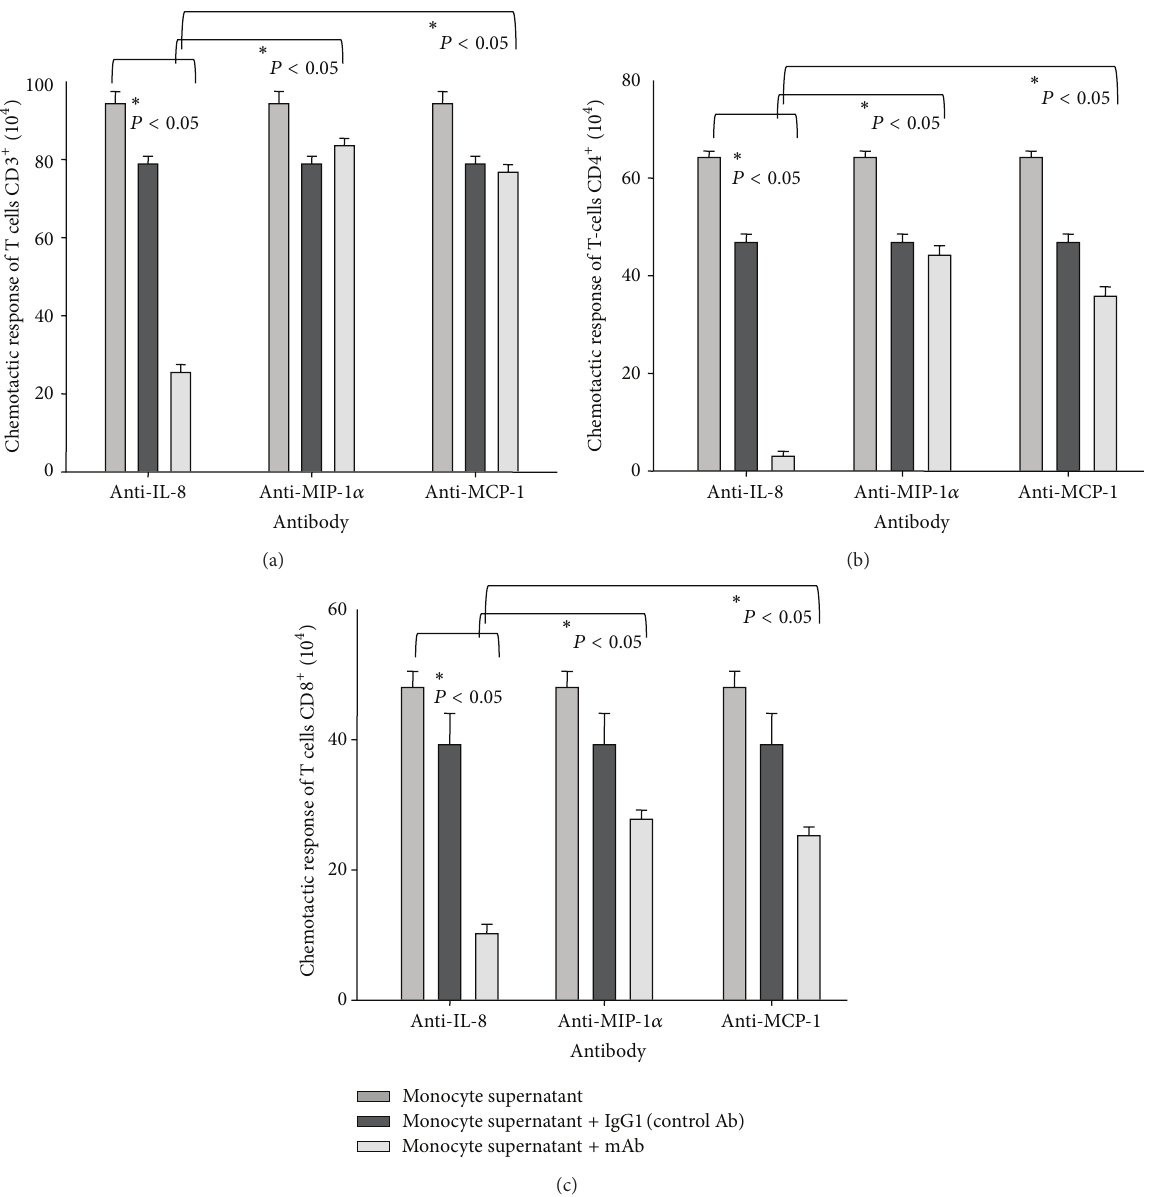
Figure 7: Chemotaxis of CD3 + (a), CD4 + (b), and CD8 + (c) cells from a healthy subject triggered by conditioned media from M. tb stimulated monocytes. Effect of anti-IL-8, anti-MIP-1 𝛼 , and anti-MCP-1 antibodies.